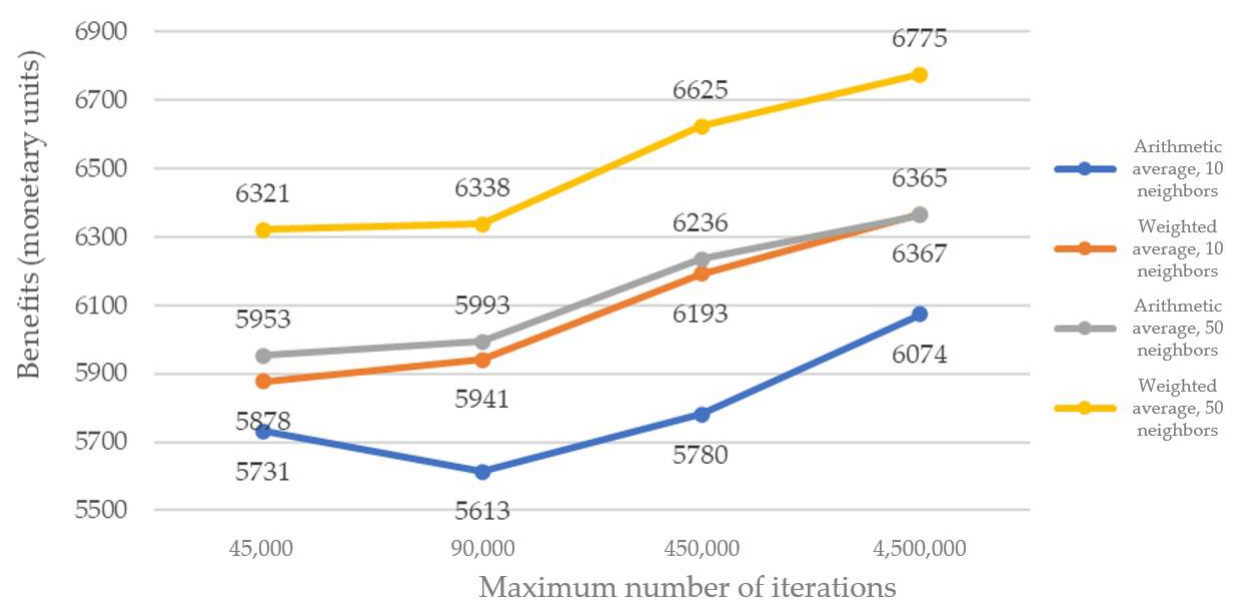
Figure 2. Comparison of arithmetic vs. weighted average and 10 neighbors vs. 50 neighbors.